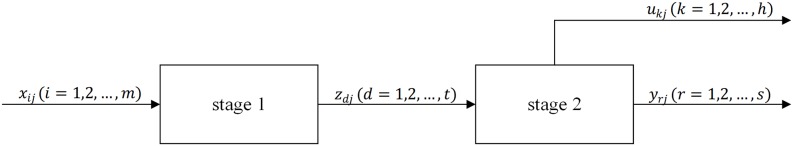
A two-stage system with undesirable outputs.